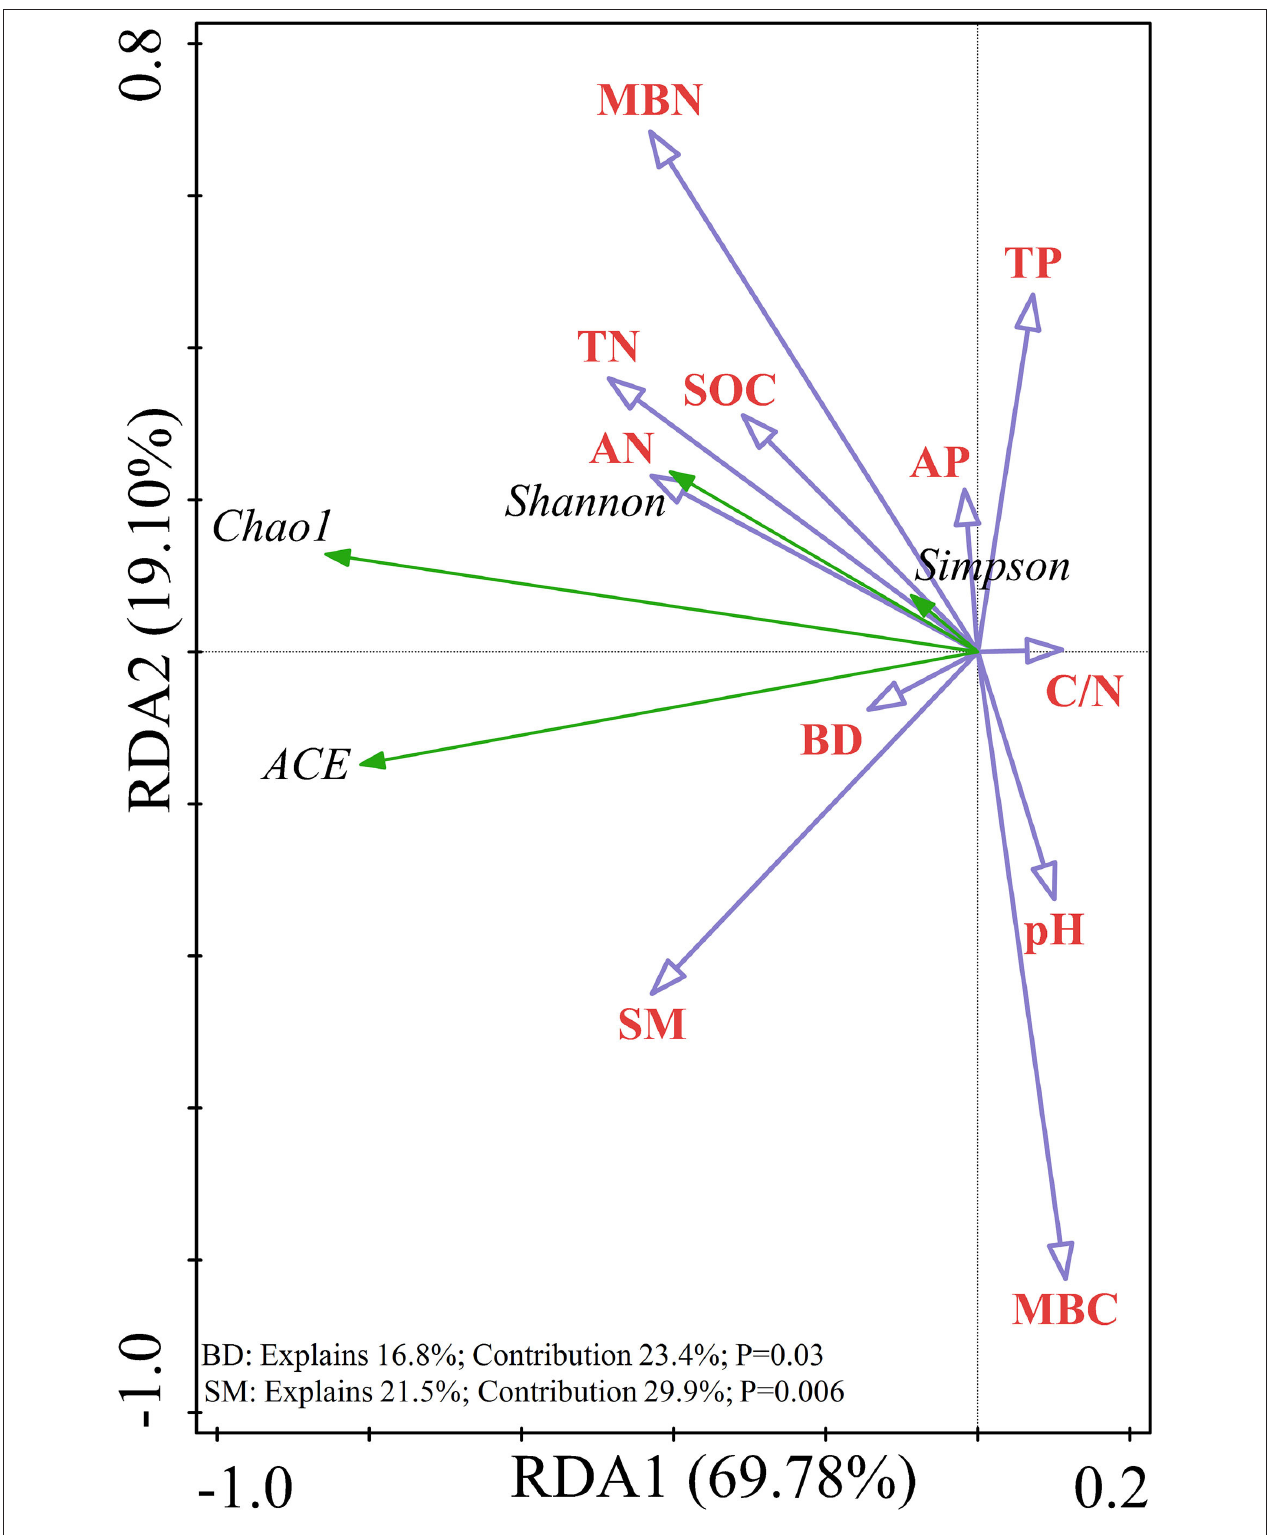
FIGURE 6 | Redundancy analysis (RDA) showing the relationship between soil variables and soil bacterial alpha diversity.